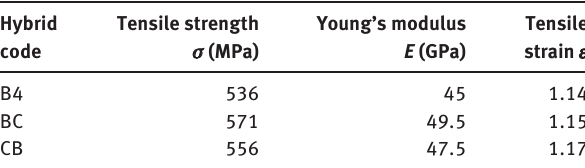
Table 3 Effect of the positioning of basalt or carbon fiber in the hybrid epoxy